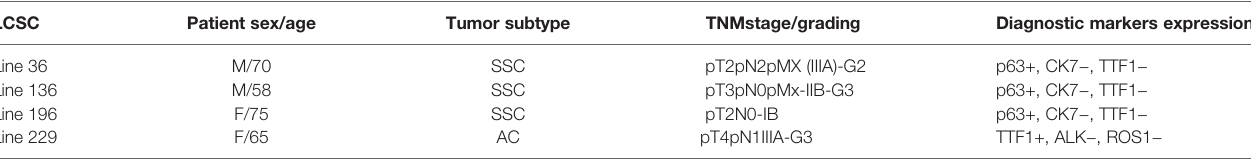
TABLE 1 | Patient ’ s clinical